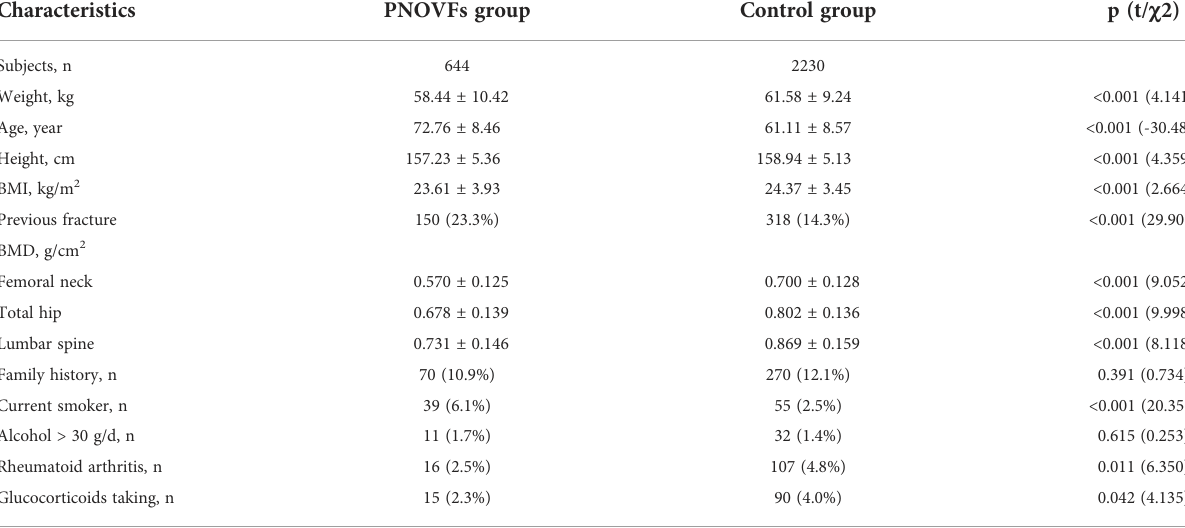
TABLE 2 Summary of descriptive characteristics of PNOVFs Group and Control Group.